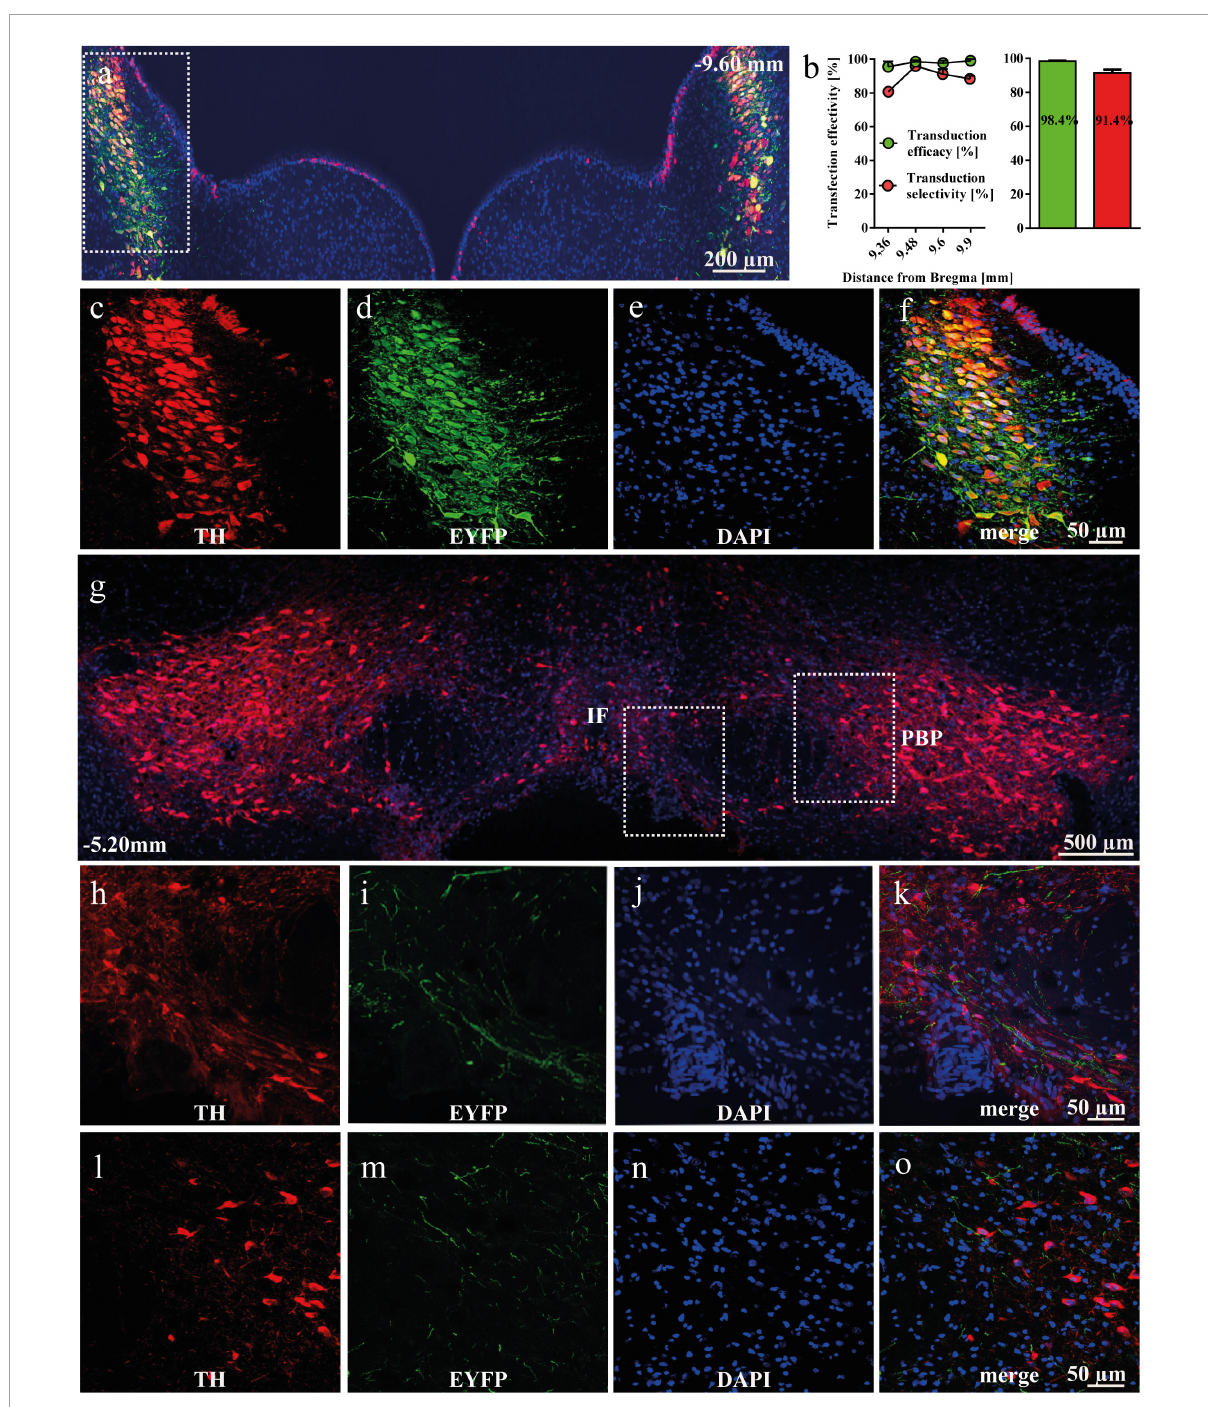
FIGURE1 Viral transduction of noradrenergic (NA) neurons in the locus coeruleus (LC) of tyrosine hydroxylase (TH)-Cre + rats. (a) Representative image of enhanced yellow fluorescent protein (EYFP)-expressing and TH-immunopositive cells in the LC. (b) The effectivity and selectivity of transduction were evaluated in TH-Cre + rats ( n = 3) 5 weeks after AAV5-EF1a-DIO-EYFP intra-LC micro-injection. Data is shown as mean ± SEM. (c–f) Magnified cells with TH (red), EYFP (green), DAPI (blue) and merged channels, showing co-localized TH and EYFP expression. (g) EYFP-expressing NA-ergic terminals from the LC are present in the ventral tegmental area (VTA). Representative panoramic image of the VTA of a rat transduced with AAV5-EF1a-DIO-EYFP into the LC. (h–k) Representative image of EYFP-positive terminals from the LC arriving into the IF, with TH in red, EYFP in green, DAPI in blue and merged channels. (l–o) Representative image of EYFP-positive terminals from the LC arriving into the PBP, with TH in red, EYFP in green, DAPI in blue and merged channels. IF, intrafascicular nucleus; PBP, parabrachial pigmentated